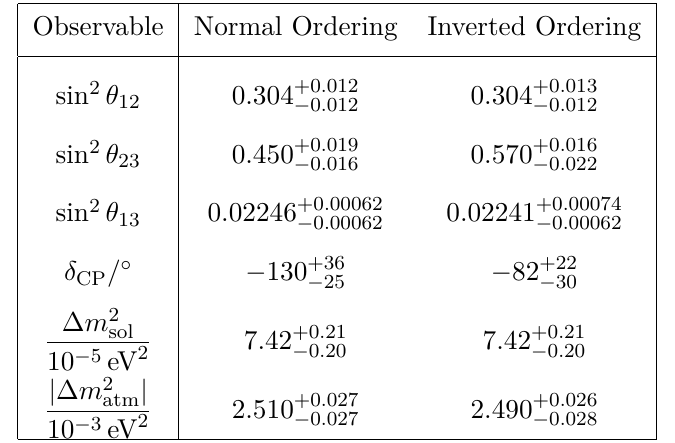
Table 3 . Three-flavour oscillation parameters from ref. [94]. The mixing angles and the Dirac CP phase are defined in eq. (3.8), while the mass squared differences are defined as ∆ m 2